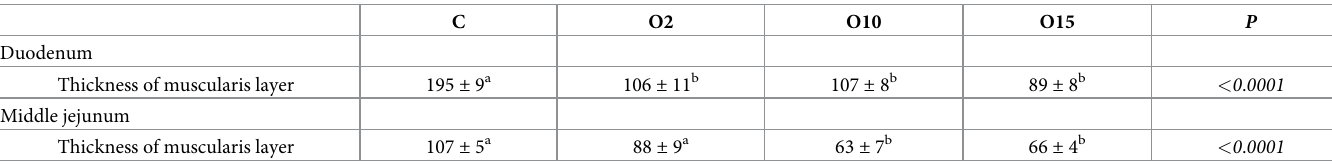
Table 5. Effect of intra-stomach obestatin administration on the thickness of muscularis layer [ μ m] in duodenum and middle jejunum of piglets.